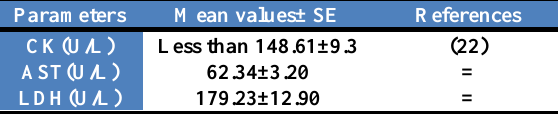
Table, 2: The normal mean values± SE of CK, AST, and LDH of the synovial